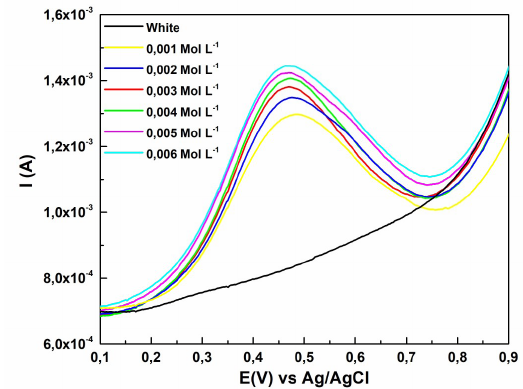
Figure 3. SWV voltammograms of the oxidation peak of the species Fe 3+ in ethanol.